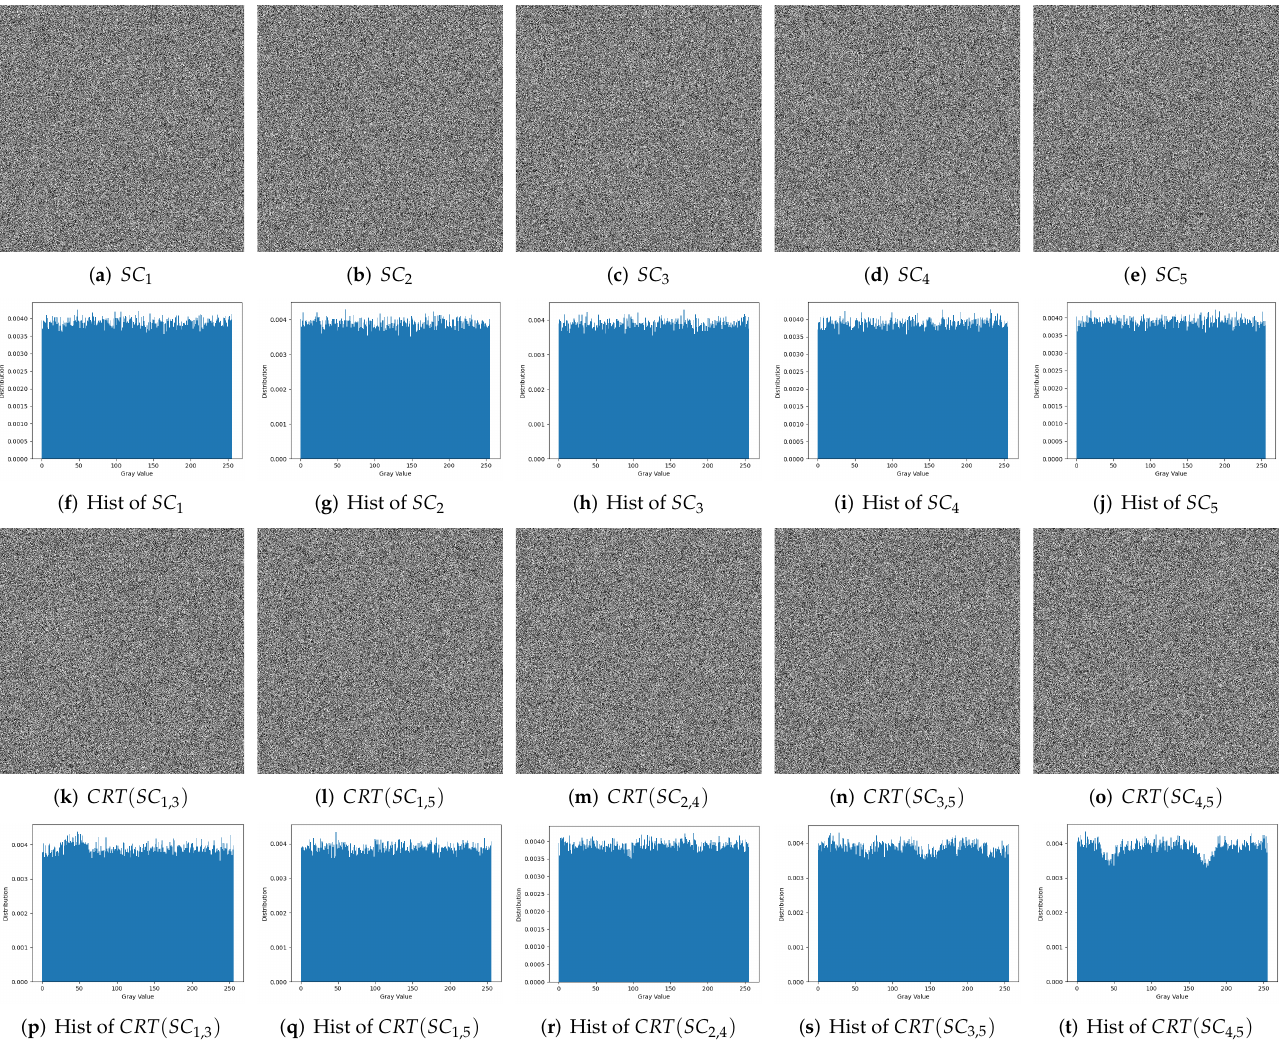
Figure 10. Experimental results of the introduced scheme for the ( 3,5 ) threshold and A in (cid:104) (cid:106) (cid:107)(cid:105) M − 2 1, . ( a – e ) Five generated shares SC 1 , SC 2 , SC 3 , SC 4 and SC 5 ; ( f – j ) histograms of the p shares; ( k – o ) five recovered images with two shares; ( p – t ) histograms of the recovered